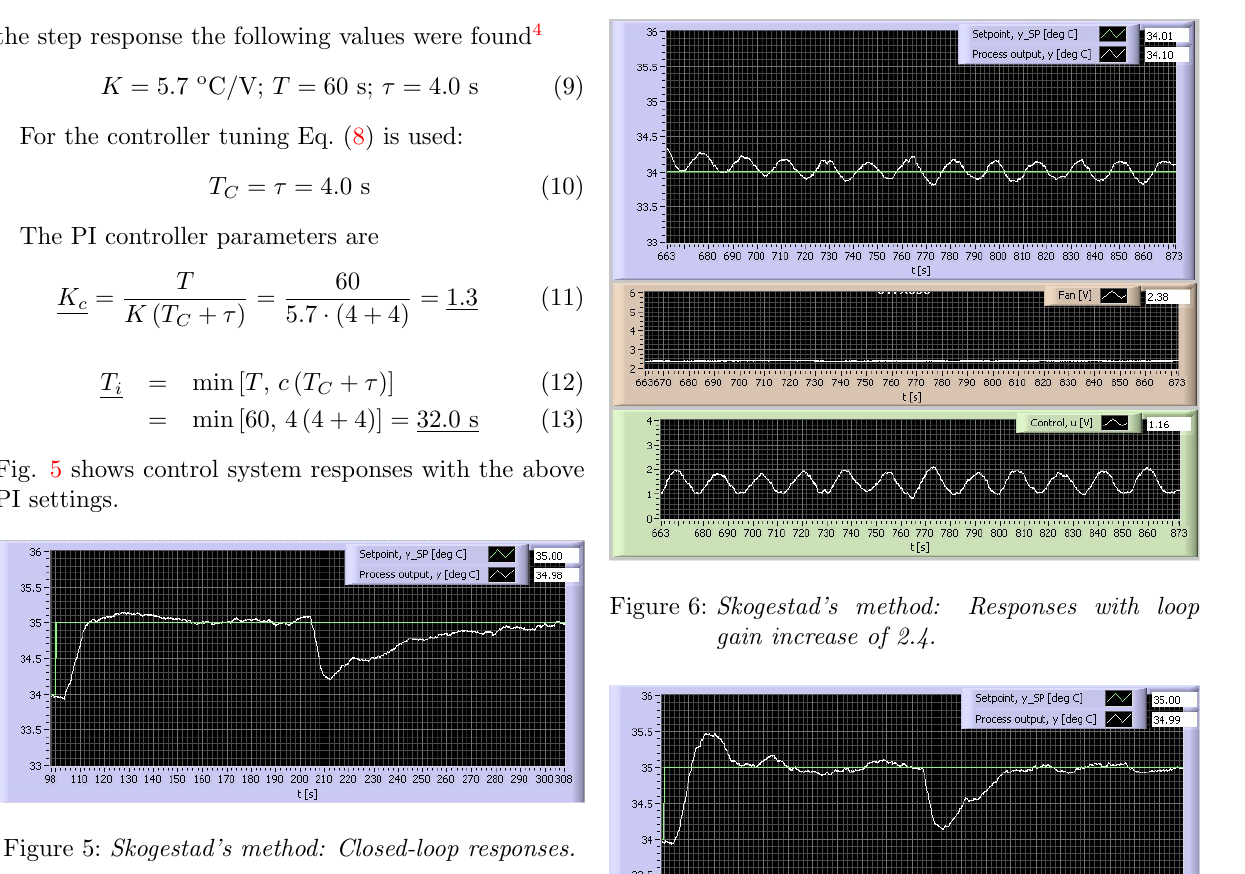
Figure 7: Skogestad’s method: Closed-loop responses with c = 2